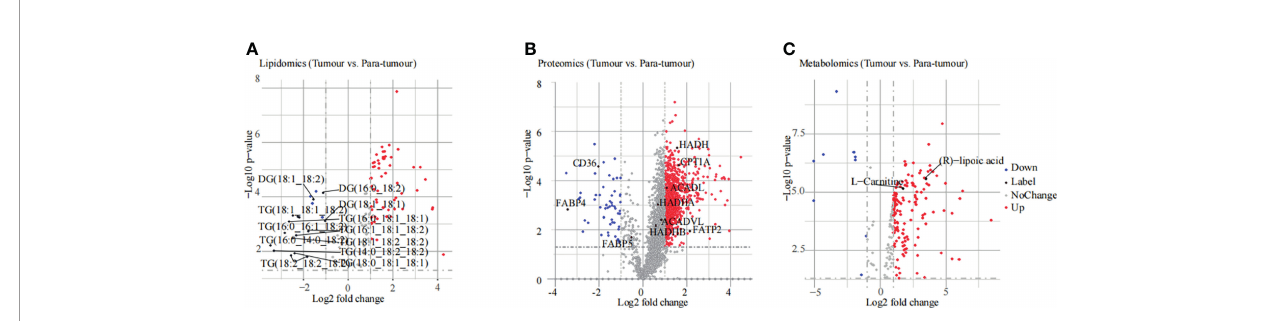
FIGURE 2 | Results of multi-omics analysis. (A, B) The differentially expressed substances identi fi ed using lipidomic (A) , proteomic (B) , and metabonomic (C) analyses are displayed in the volcano plot. The red plots indicate an increase in expression, blue plots indicate a decrease in expression, grey plots indicate no change, and black plots indicate